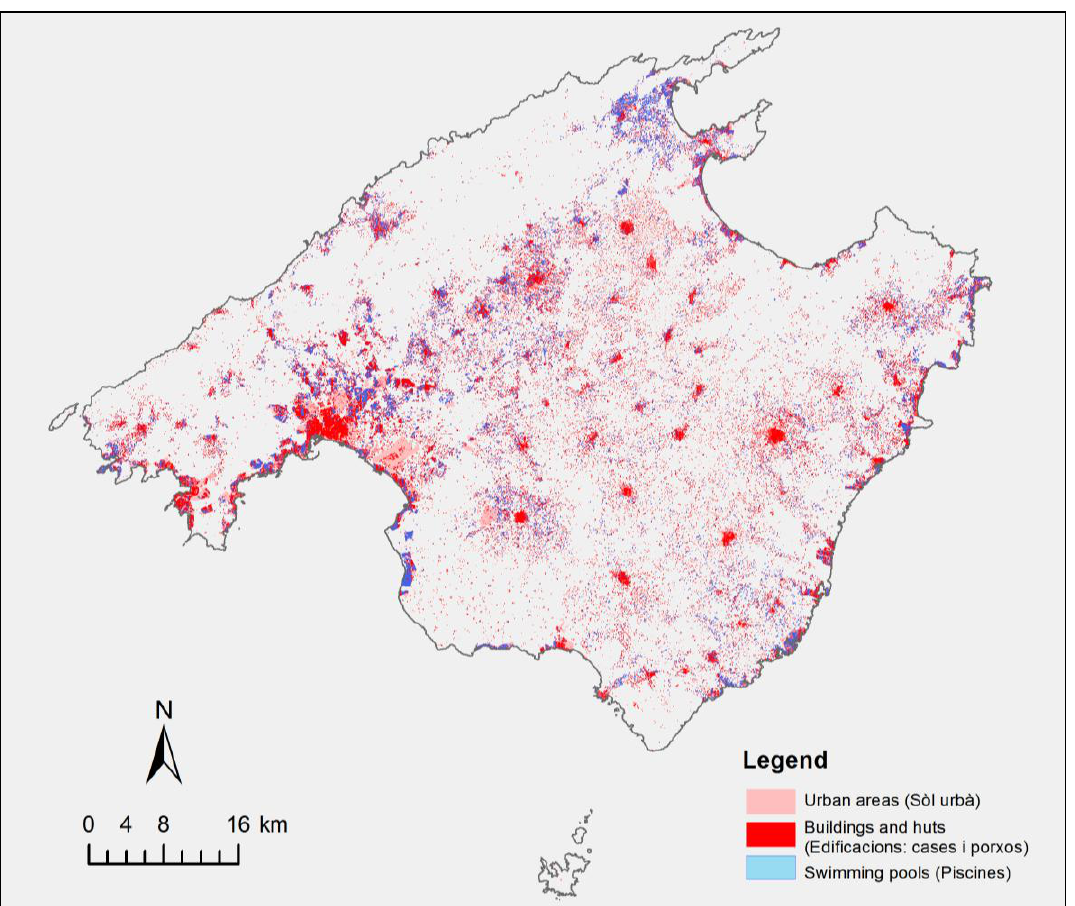
Figure 6. Swimming pools associated with human dwellings usable as residential houses in Majorca from the Topographic Map of the Balearic Islands (2006), reprinted with permission from Sitibsa S.A., Palma (Majorca). Northernmost empty areas correspond to mountainous